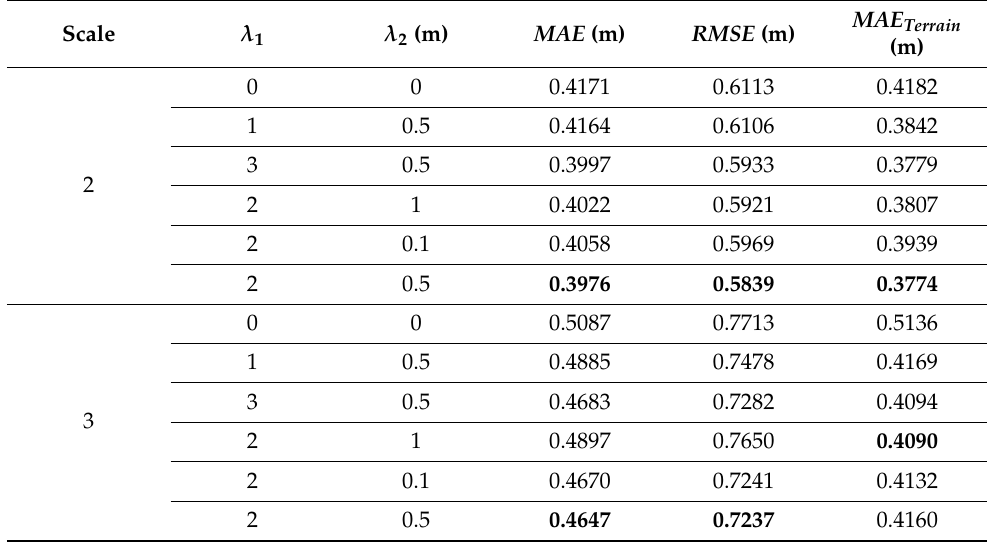
Table 7. Comparison of the performance of the ERFFN trained using different parameters of the terrain loss module for different reconstruction